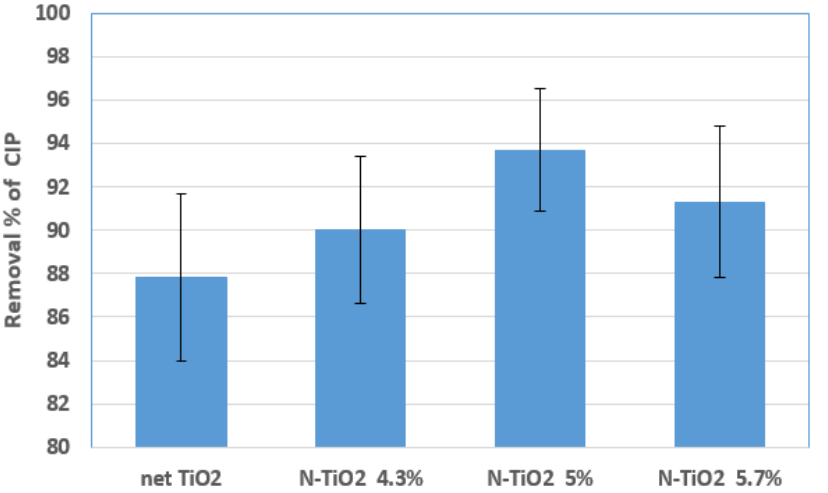
Figure 5. Variation in removal efficiency against wt% N-doped TiO 2 at initial concentration of CIP = 30 ppm, pH = 5, and feed flow rate = 0.4 L/min.